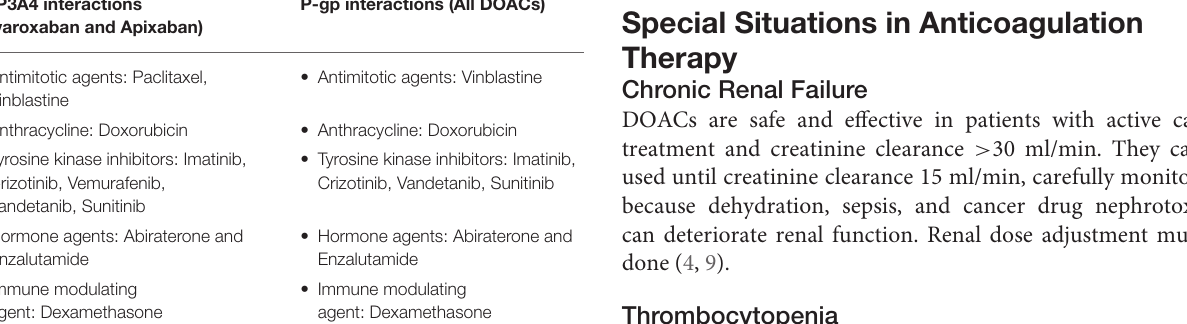
P-gp interactions (All